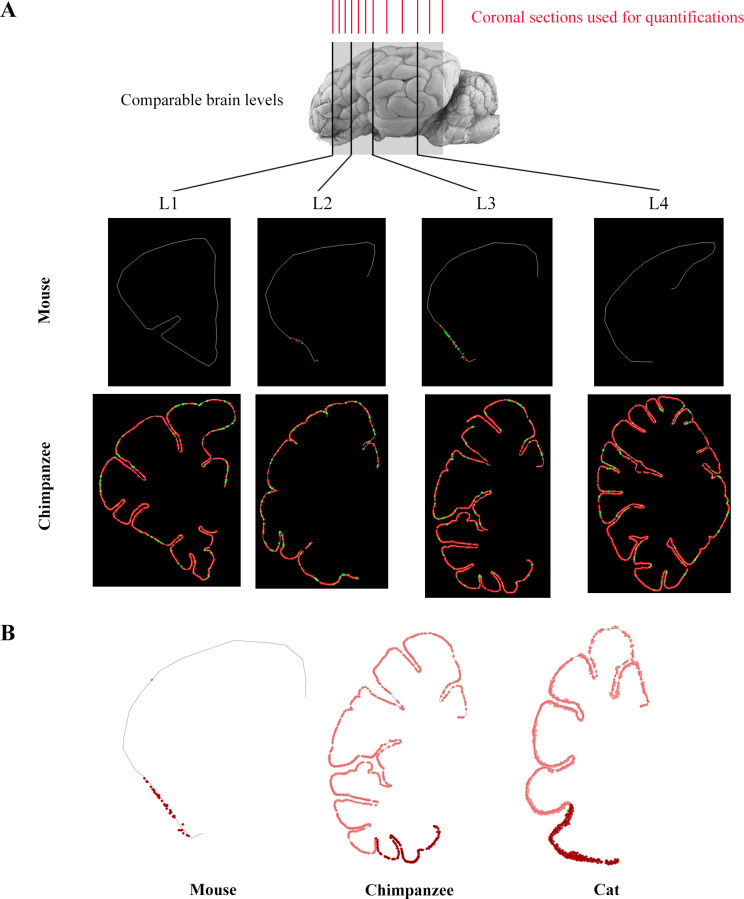
Quantification of DCX+ cells (linear densities in the cortical layer II).(A) Representative sections from each level (L1–L4) of mouse and chimpanzee brain obtained with Neurolucida software. The contour of cortical layer II is shown in white and the location of DCX+ cells have been marked (type 1 as red dots, type 2 as green dots). Top, red: 12 cryostat coronal sections used for the quantification of linear densities in 80 mammalian brains. (B) Representative coronal sections at level 3, demonstrating the density and localization of layer II cortical DCX+ cells (dark red, cells in the paleocortex; pink dots, cells in the neocortex).